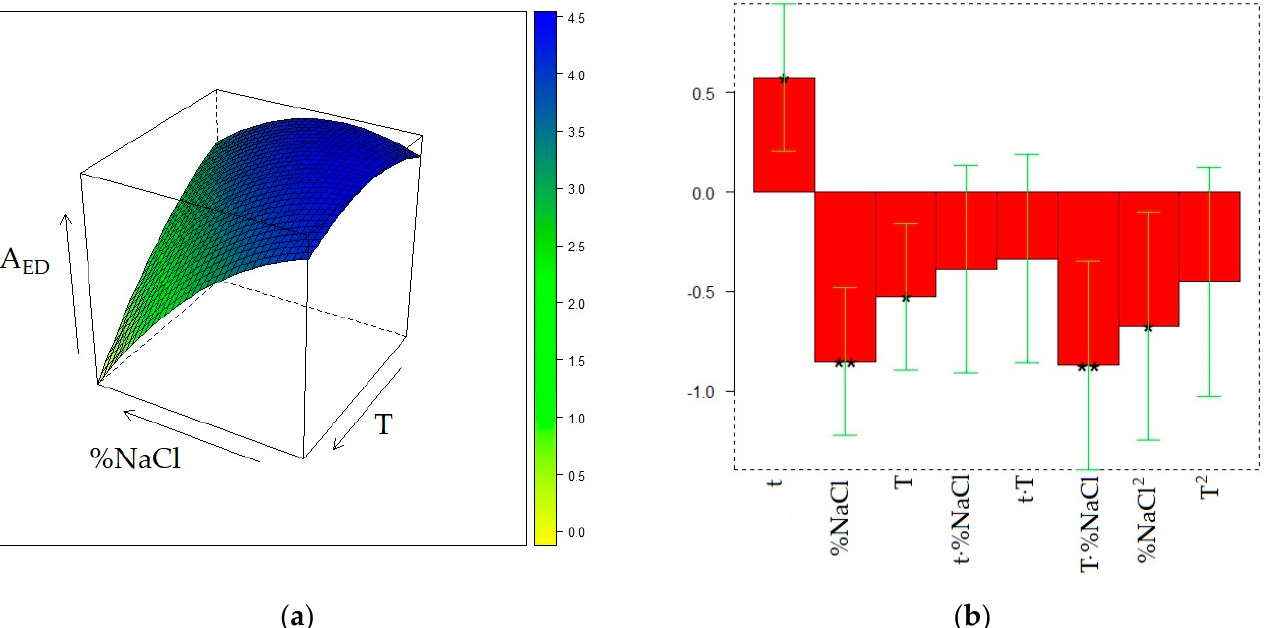
Figure 2. Optimization of HS-SPME profiling of wine volatiles extracted with the PDMS fiber: ( a ) response surface for the peak area of ethyl decanoate (A ED ) at t = 30 min; ( b ) coefficients of the surface model; p < 0.05 (*), p < 0.01(**).